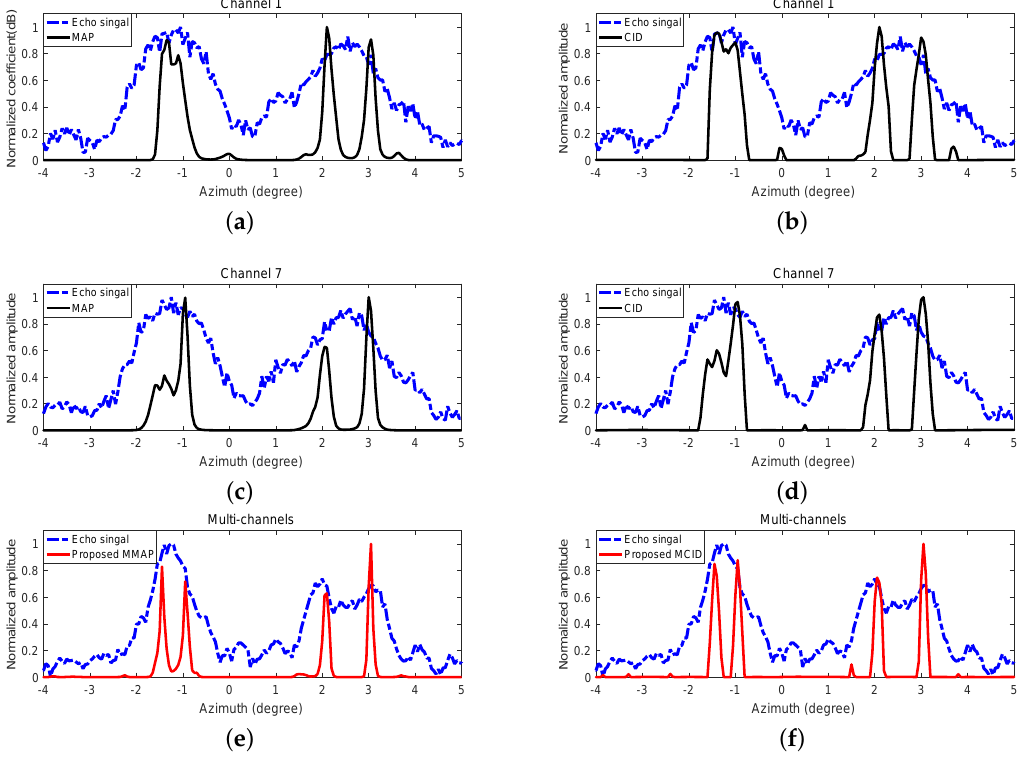
Figure 9. Received echo signal and super-resolution results when SNR = 20 dB . ( a , b ) MAP and CID of Channel 1; ( c , d ) MAP and CID of Channel 7; ( e ) Proposed MMAP; ( f ) Proposed